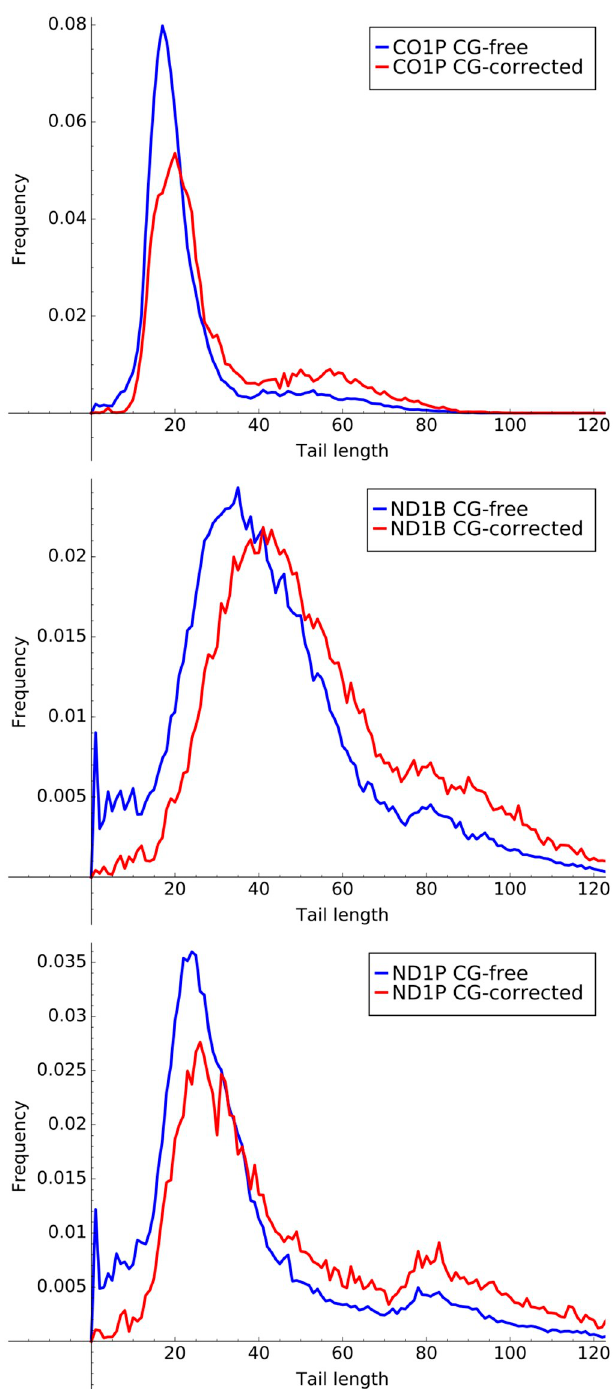
Fig 12. Error corrected tail lengths. Histograms of tail lengths for ex-tail containing datasets CO1P, ND1P, and ND1B inclusive and exclusive of sequences containing corrected G and C erroneous nucleotides.